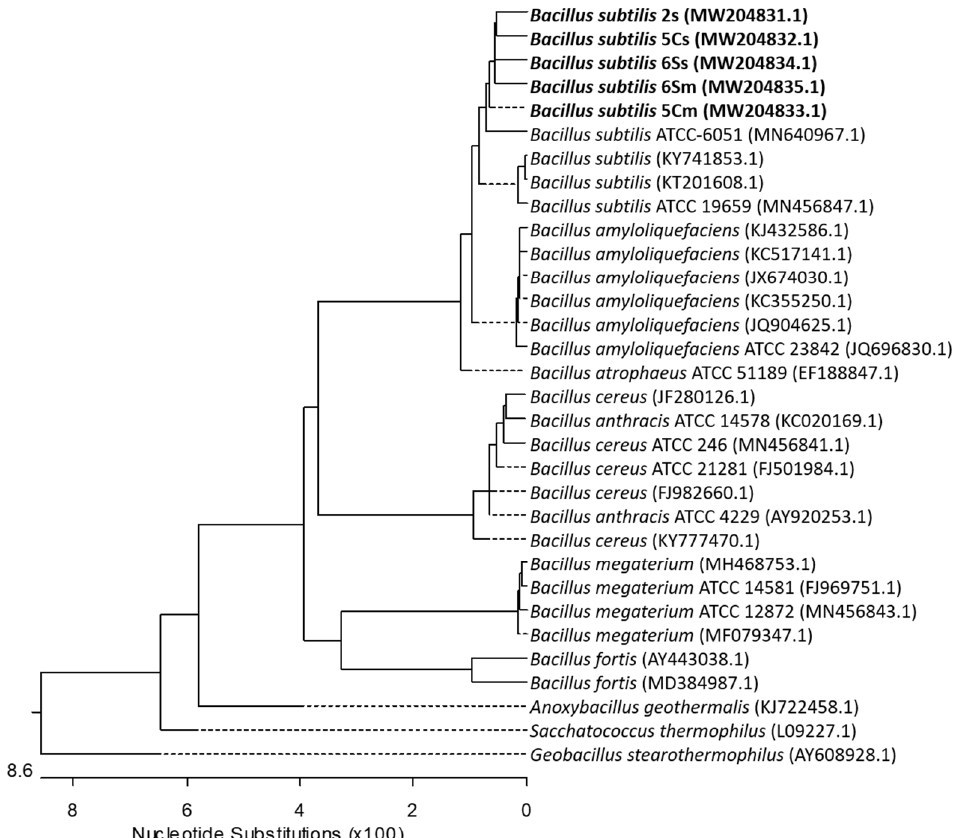
Figure 4. Neighbor-joining tree derived from 16S-rRNA gene sequences of sequenced isolates and published sequences. The length of each pair of branches represents the distance between sequence pairs. A dotted line on the tree indicates a negative branch length; the bar indicates the number of nucleotide substitutions.